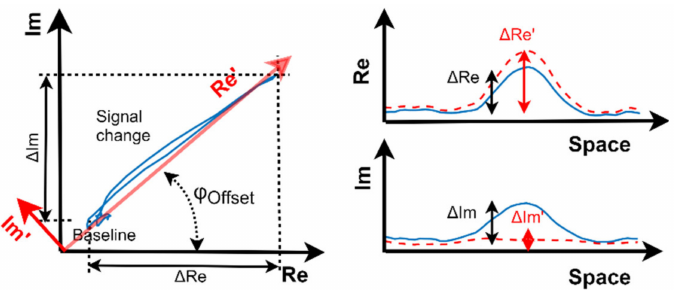
Figure 9. Effect of the phase shift in the signal phase demodulation for the signals across the black dashed line in Figure 2.